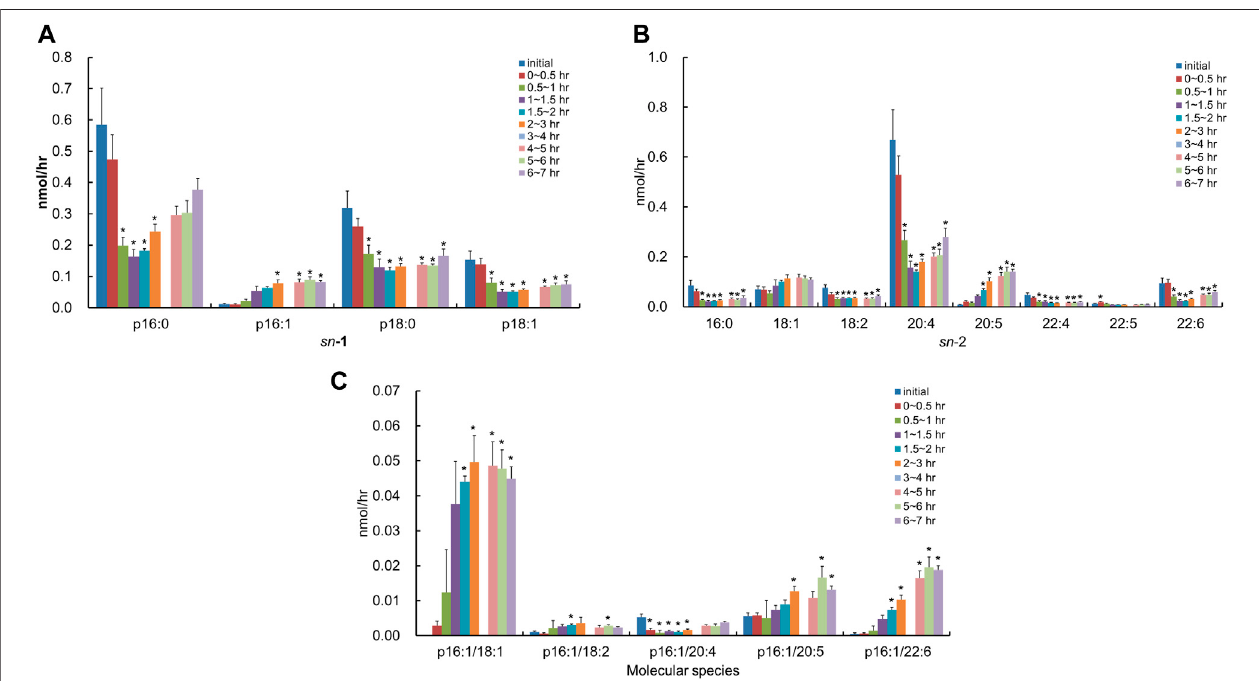
FIGURE6| Changeinmolecularspeciesduetotheclassi fi cationin (A) thehydrocarbonchainatthe sn -1positionand (B) FAatthe sn -2positionand (C) changein molecular species with p16:1 at the sn -1 position in the lymphatic PlsCho of thoracic lymph-cannulated rats for 7 h after duodenal administration of the emulsion containing the lipid extracted from S. ruminantium . Data are represented as mean ± SEM ( n = 5 – 6). Asterisk indicates signi fi cant difference with respect to the values at time 0 ( p < 0.05). The data of 3 – 4 h were missing in order to mistake analyzing.